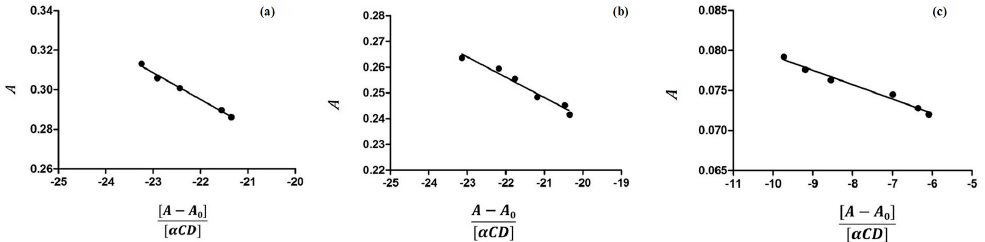
Figure 4. Dependence of 5-FU absorbance from α -CD concentration in aqueous solutions at different pH values: ( a ) pH = 4.3 ( λ = 266.6 nm); ( b ) pH = 6.8 ( λ = 266.6 nm); and ( c ) pH = 9.8 ( λ = 271.2 nm).